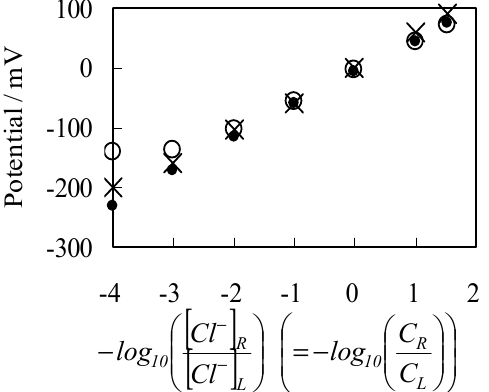
Figure 3. Potential generated between two KCl solutions vs. − log([Cl − ] anion exchange membrane separator; ×: Ag wire separator; •: potential computed by employing the Goldman-Hodgkin-Katz (GHK)